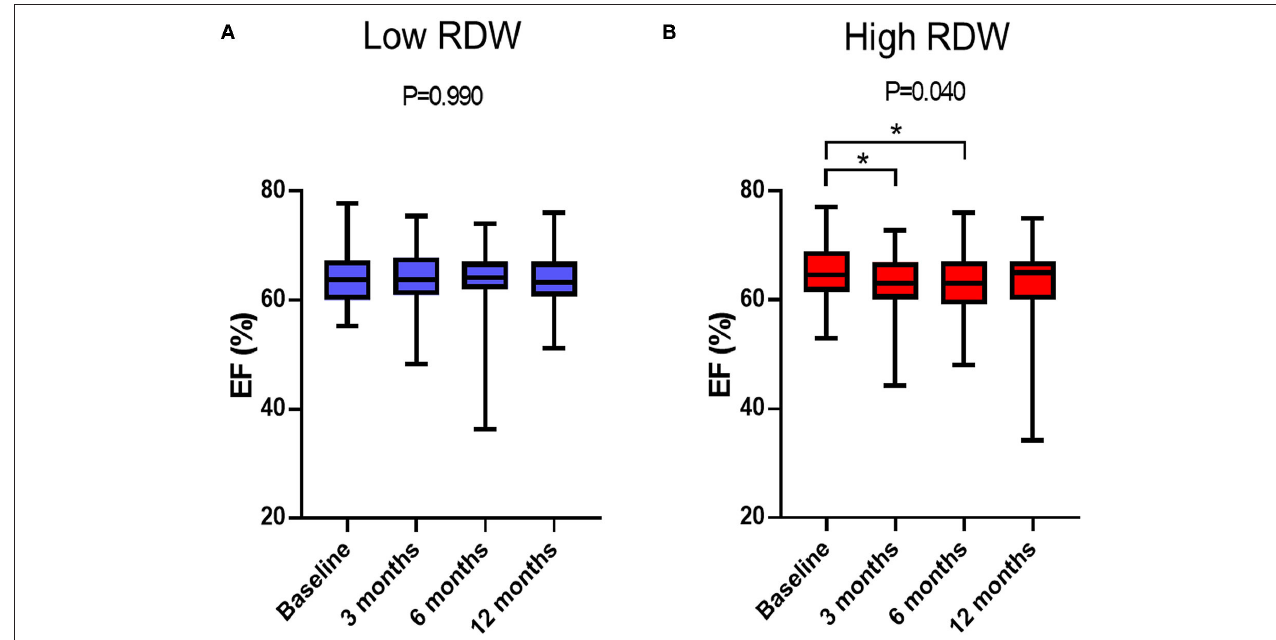
FIGURE 2 | Time-dependent changes in EF after anthracycline treatment. (A) Changes in EF in low RDW group. (B) Changes in EF in high RDW group. * P < 0.05.